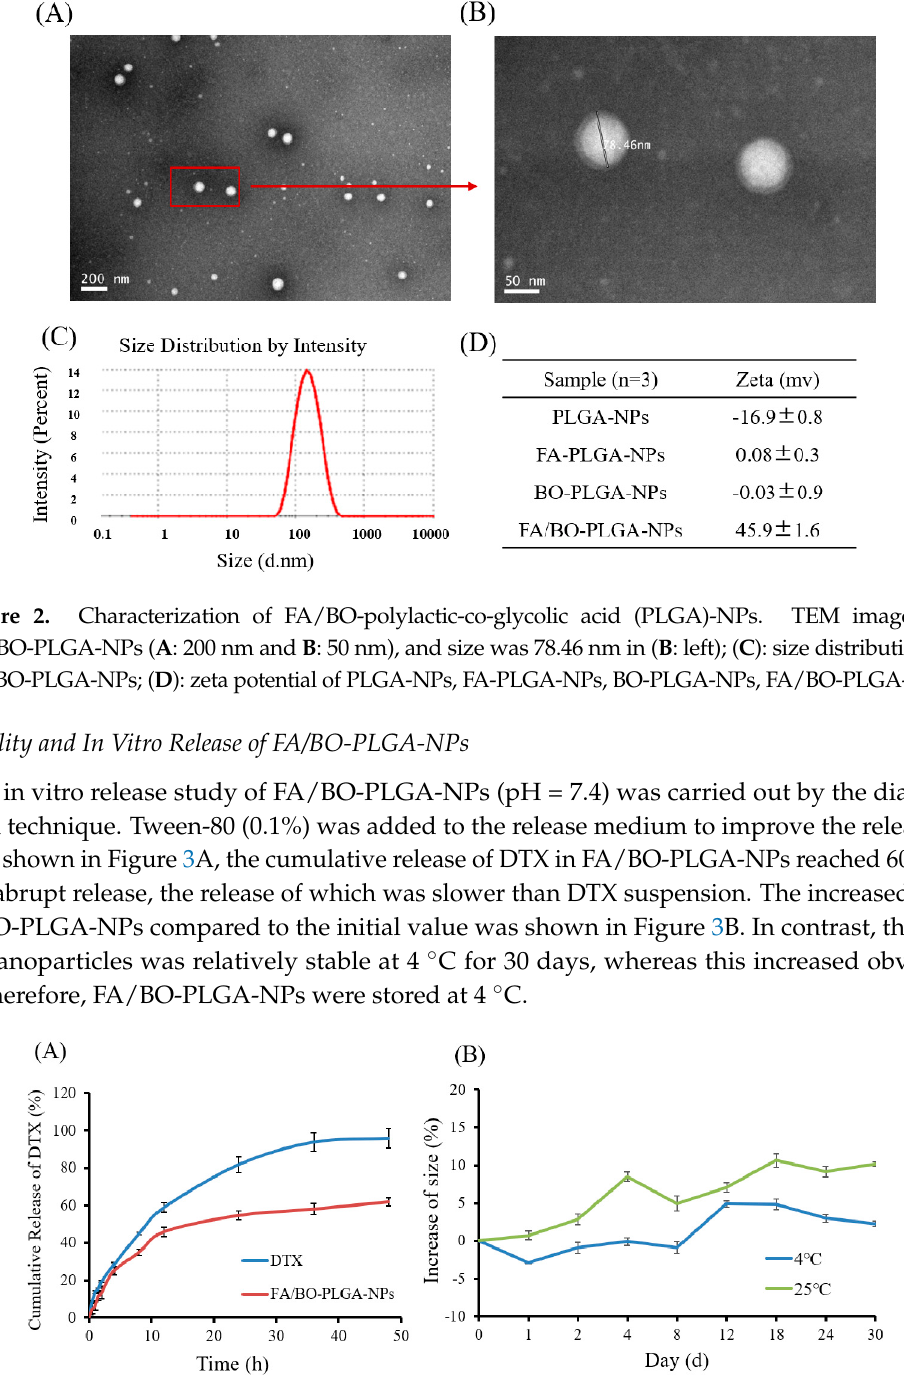
Figure 3. ( A ): Cumulative release of DTX in FA/BO-PLGA-NPs; ( B ): stability of FA/BO-PLGA-NPs: size change of nanoparticles within 30 days.